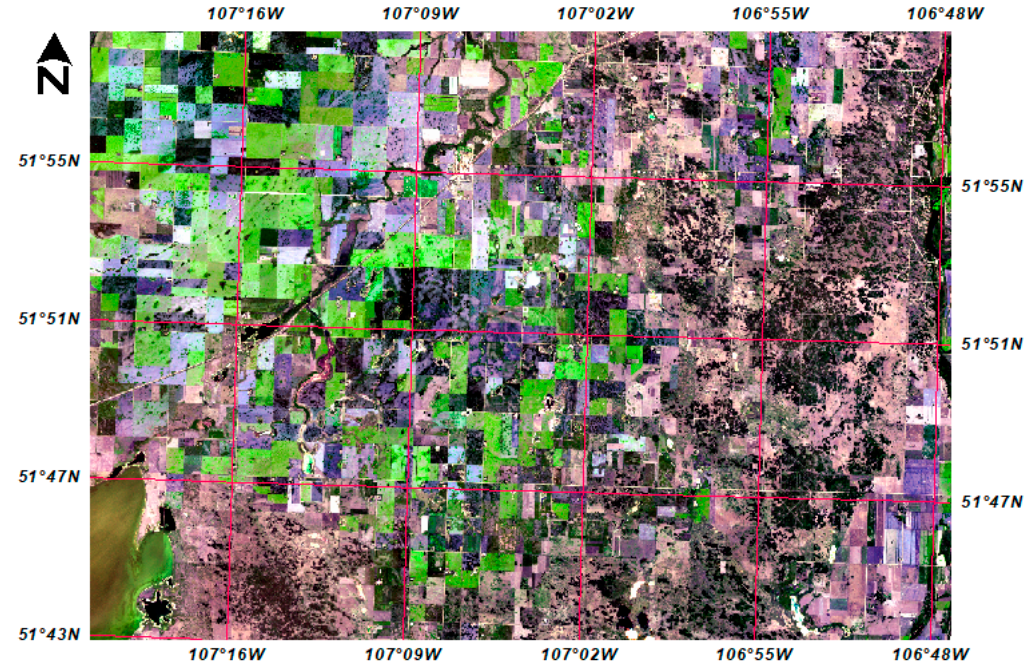
Figure 4. The study area (28 × 40 km) in Saskatchewan, Canada.